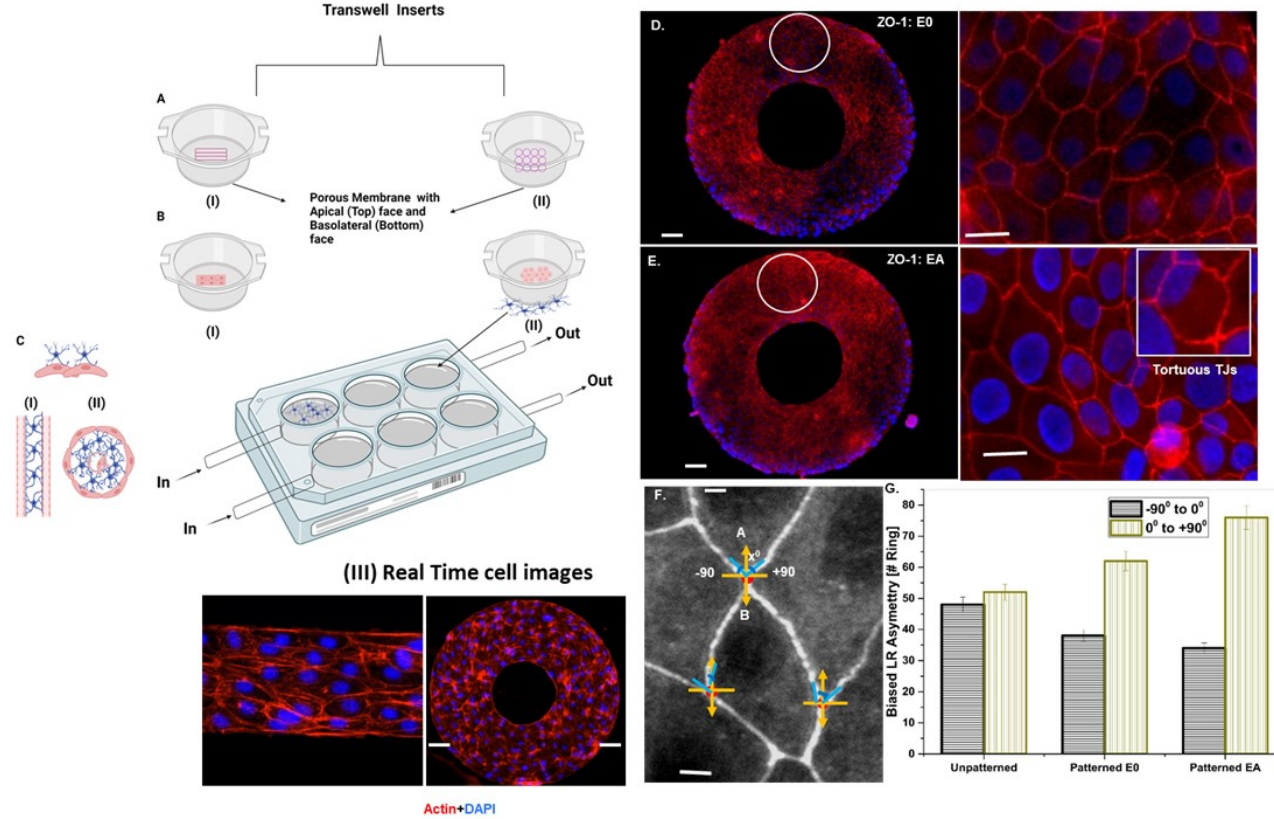
Figure 2. Development and characterization of micropatterned co-culture of HUVECs and astrocytes for in vitro BBB design: ( A – C ) Two micropatterns in the form of ( I ) line and ( II ) ring patterns developed on transwells by culturing endothelial cells on line/ring patterns; ( III ) Real time cell images; ( D – F ) tortuous and chiral expressions of ZO-1 tight junctions at the BBB from endothelial– astrocyte (EA) co-culture in the contact mode, with the astrocytes cultured at the transluminal surface ( bottom ) of the transwell insert ( B ) versus the astrocytes cultured in the routine culture well ( C ); ( G ) quantification of the L–R asymmetric distribution of the TJs (scale bar: ( D – E ) left and right magnified panels: 50 and 20 µm, respectively; ( F ) 10 µm).